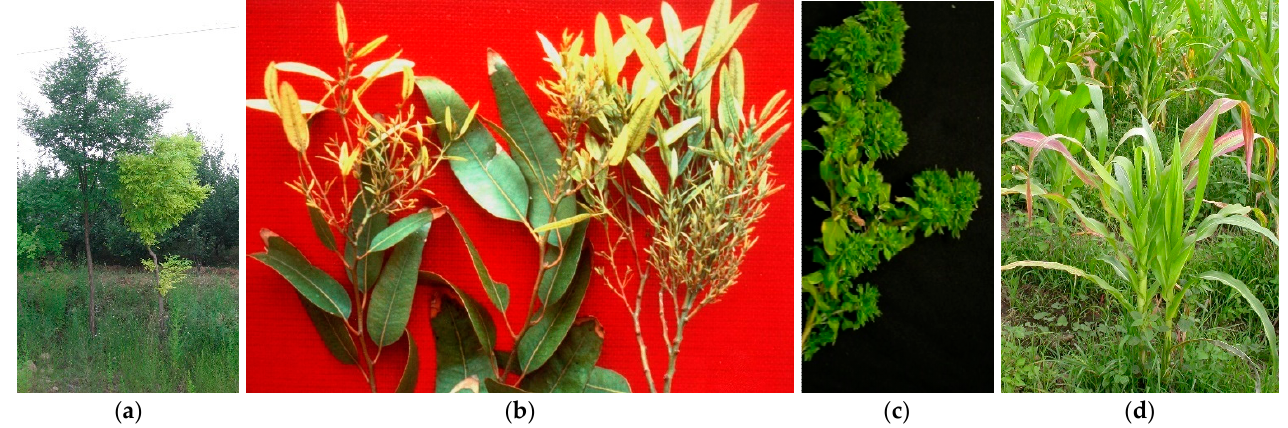
Figure 4. Sophora japonica stunting and yellows ( a ); Eucalyptus little leaf ( b ), periwinkle little leaf ( c ), and corn stunting ( d ).